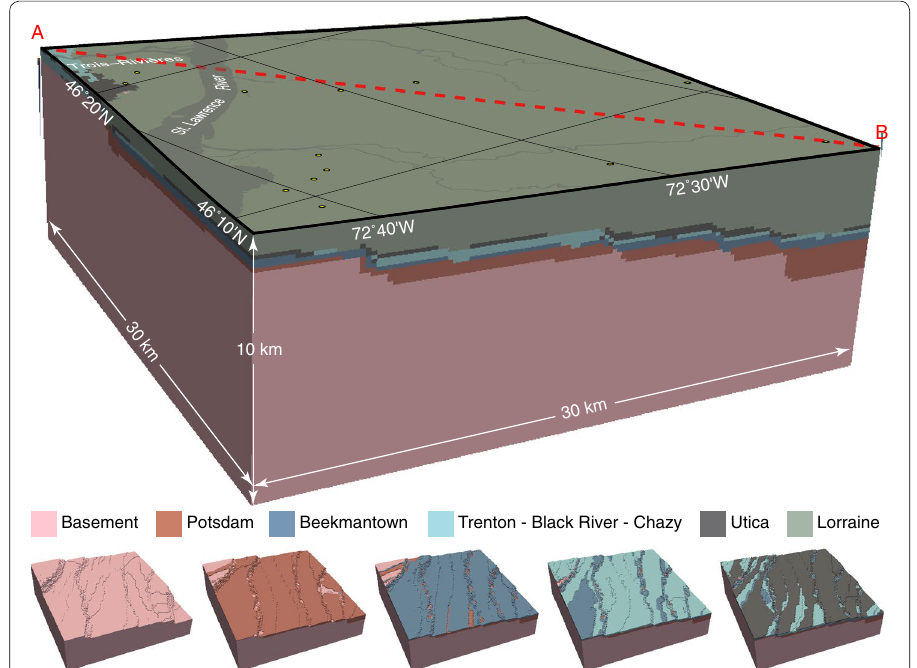
Fig. 5 3D views of the geological model. 3D views of the geological model in the selected region after discretization. The red dashed line represents the location of profile A – B that crosses the model from shallower ( A ) to deeper basement ( B